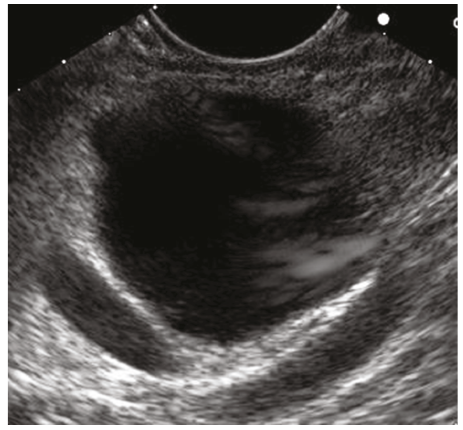
Figure 3: Mucinous cystic neoplasm. CEA: 242ng/mL. Cytology benign.